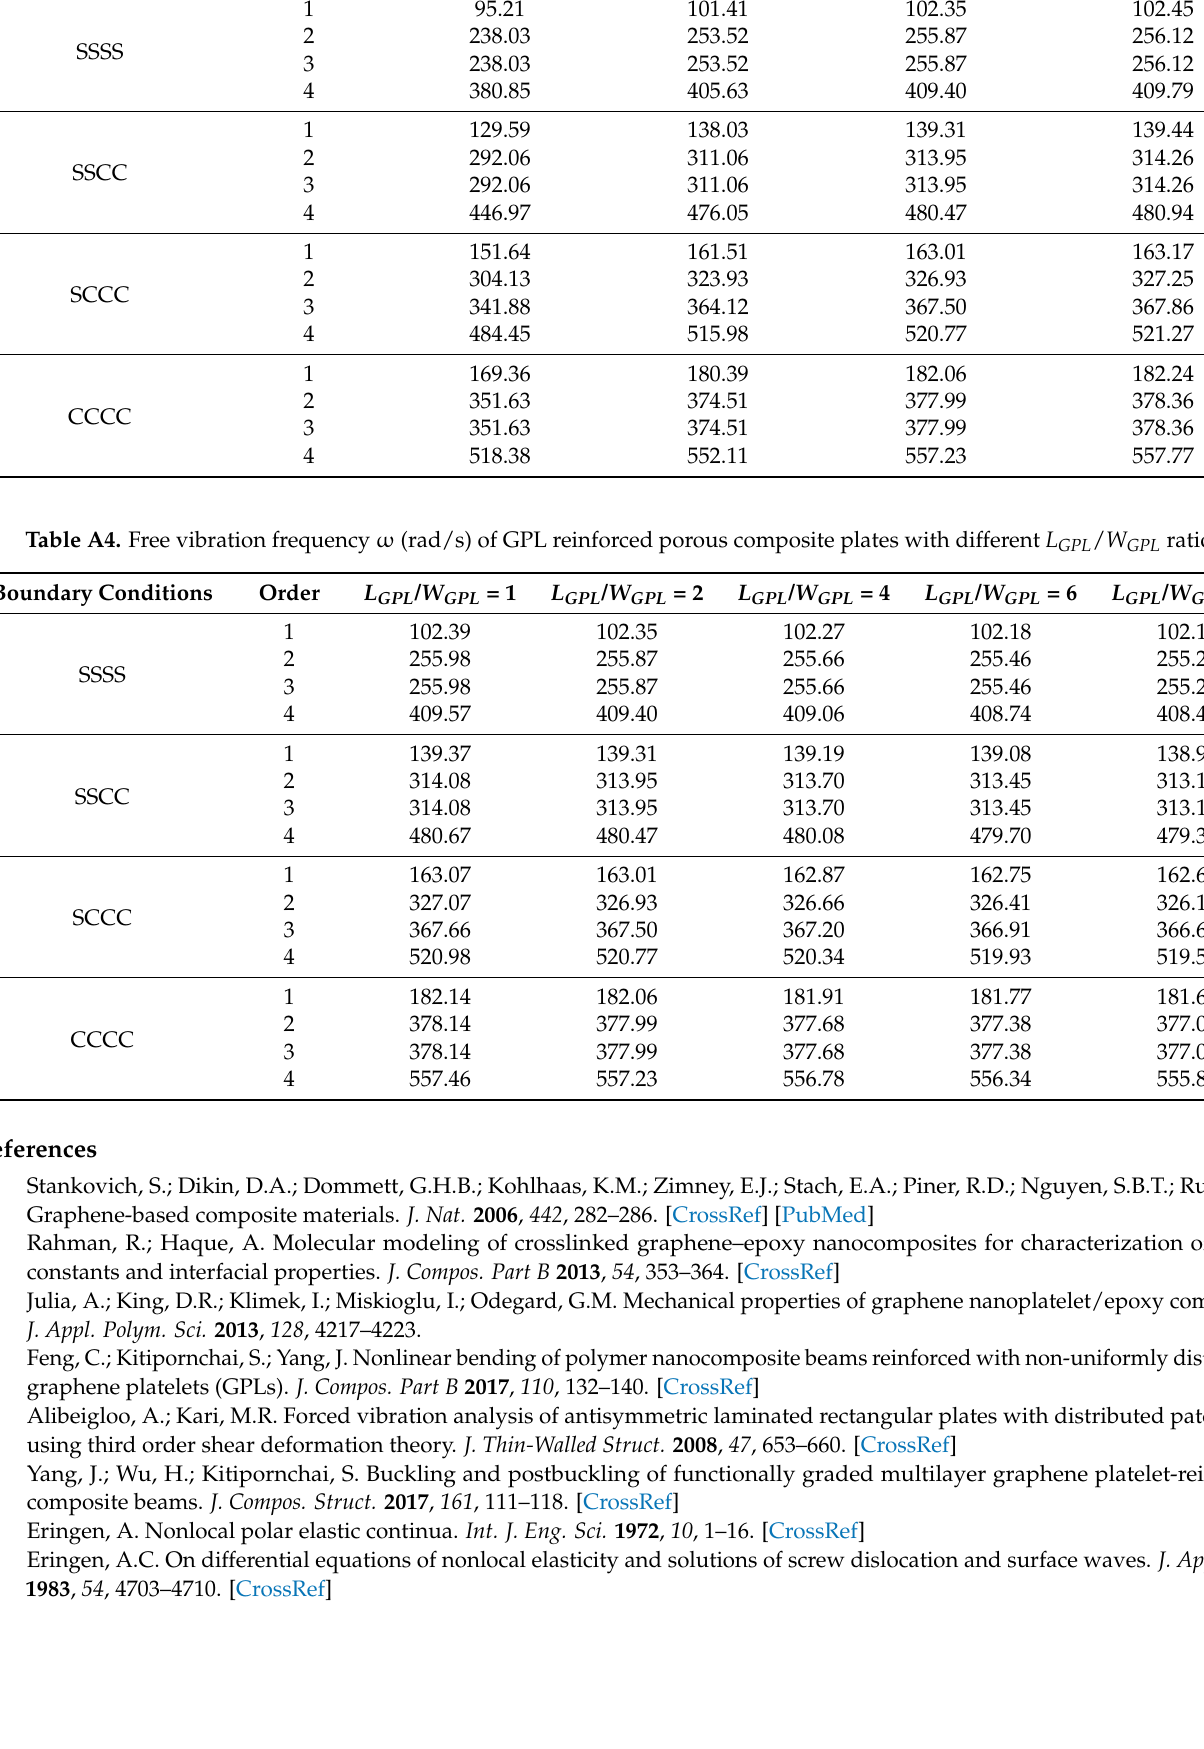
Table A3. Free vibration frequency ω (rad/s) of GPL reinforced porous composite plates with different L GPL / T GPL ratios. Boundary Conditions